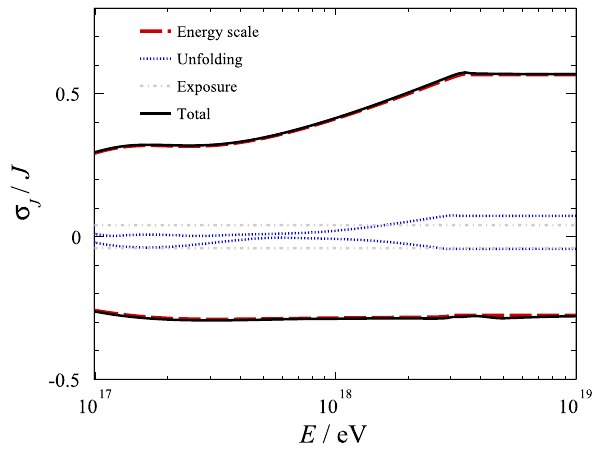
Fig. 15 Systematicuncertaintiesinthe flux measurementas afunction of energy. The main contributions are shown separately